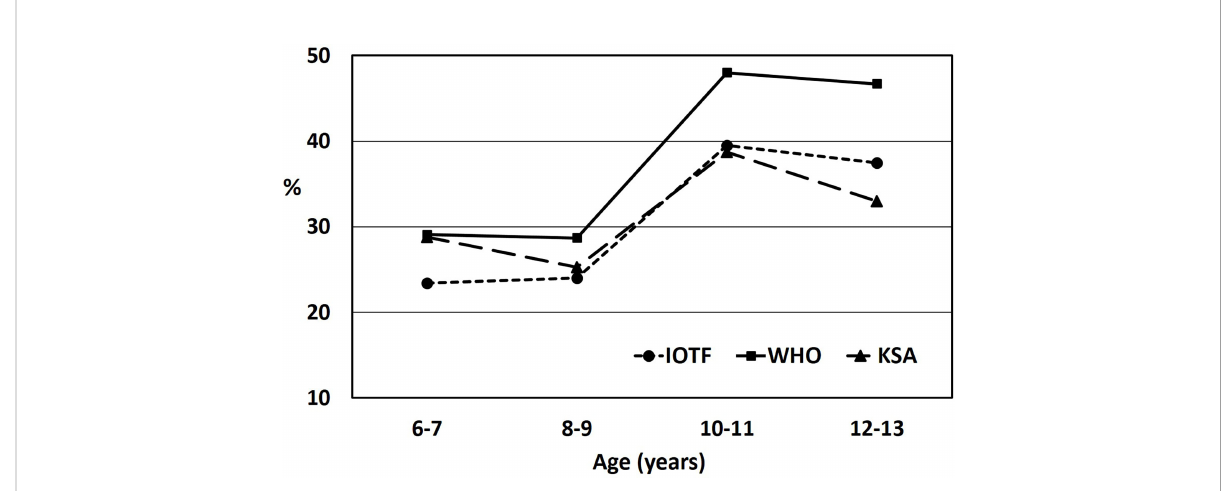
FIGURE 1 Overweight or obesity prevalence among Saudi children relative to age, based on International Obesity Task Force cut-off standards (IOTF), World Health Organization (WHO) reference standards, or Saudi (KSA) National growth references. Signi fi cant differences at p < 0.001 in all reference standards were found relative to age.